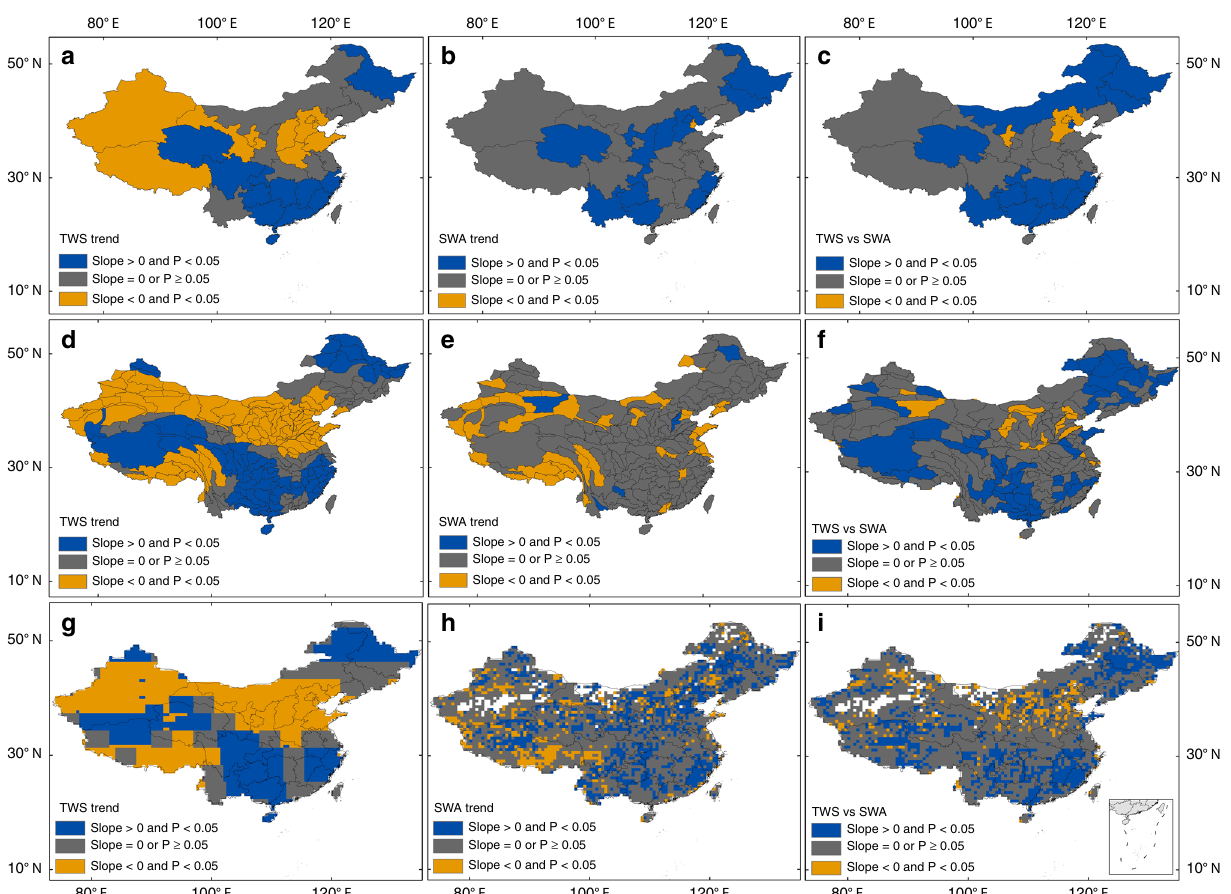
Fig. 3 Trends of year-long surface water area and terrestrial water storage, and their linear regression trends at the provincial, watershed, and 0.5° gridcell scales during 2002 – 2016 with t -test at the 5% signi fi cance level. a Trend of terrestrial water storage (TWS) at the provincial scale. b Trend of surface water area (SWA) at the provincial scale. c Trend of linear regressions between SWA and TWS at the provincial scale. d Trend of TWS at the watershed scale. e Trend of SWA at the watershed scale. f Trend of linear regressions between SWA and TWS at the watershed scale. g Trend of TWS at the 0.5° gridcell scales. h Trend of SWA at the 0.5° gridcell scales. i Trend of linear regressions between SWA and TWS at the 0.5° gridcell